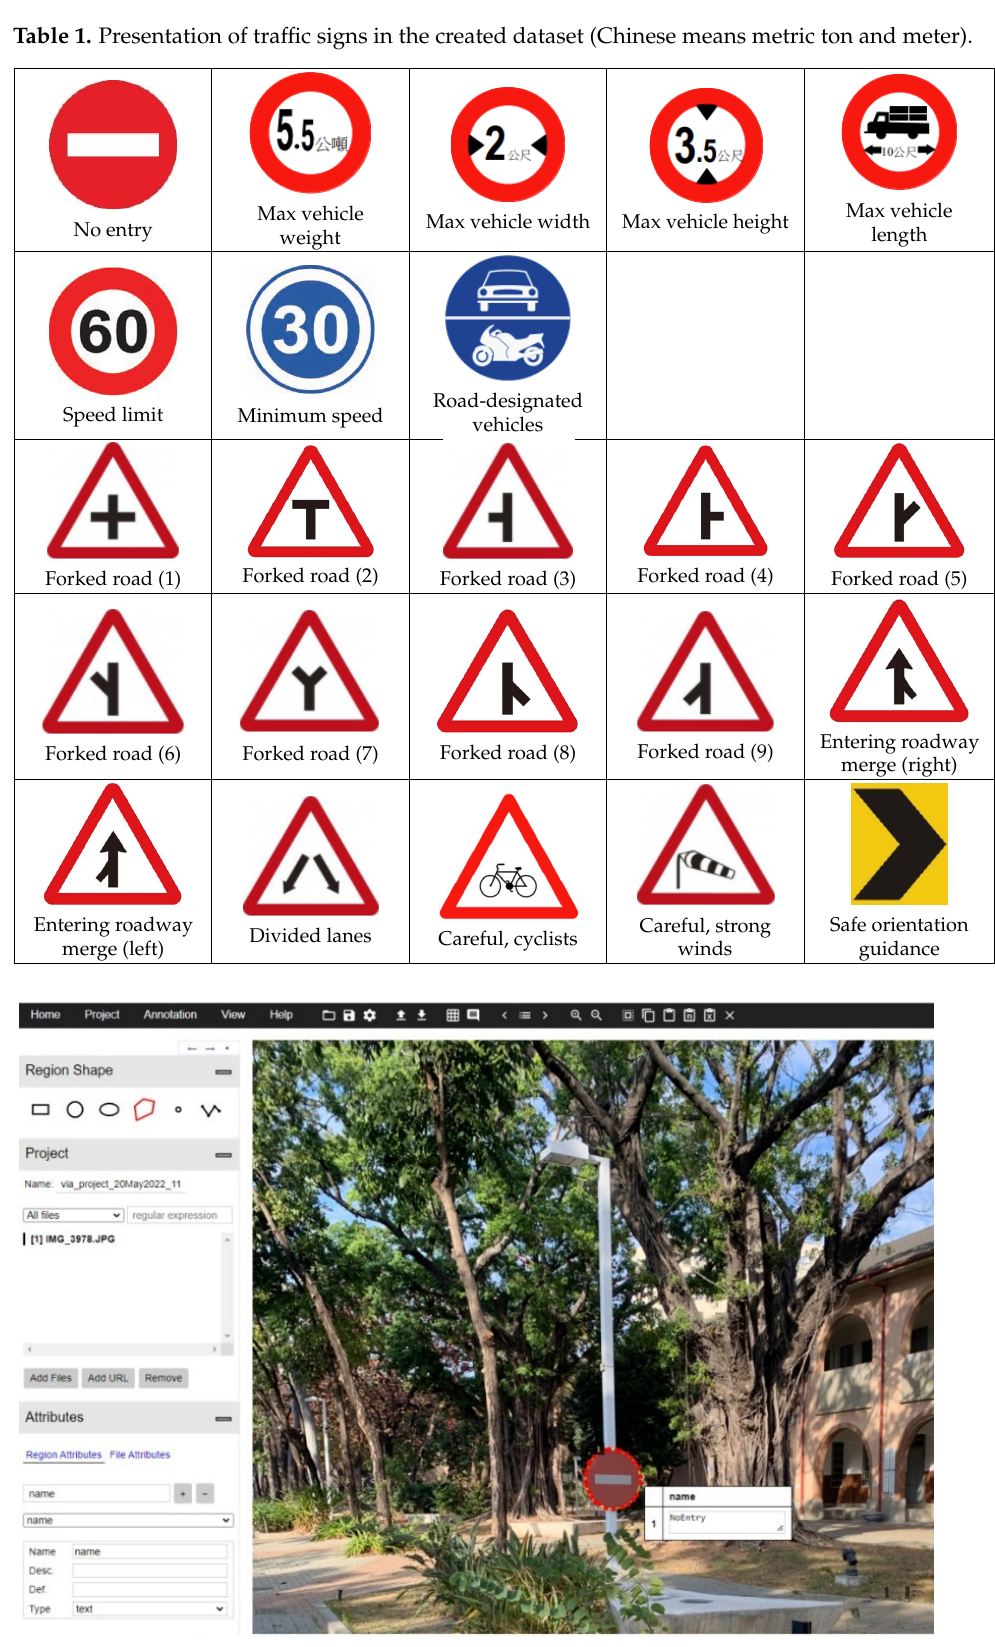
Figure 6. Dataset preparation using VGG annotating software.